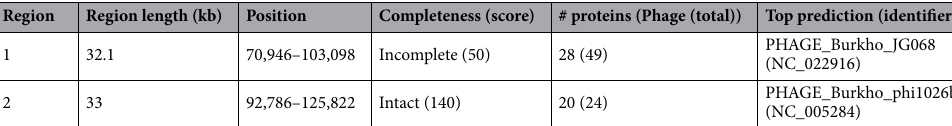
Table 3. Phage prediction for the region of B. pseudomallei BES encoding Bsp-lig.